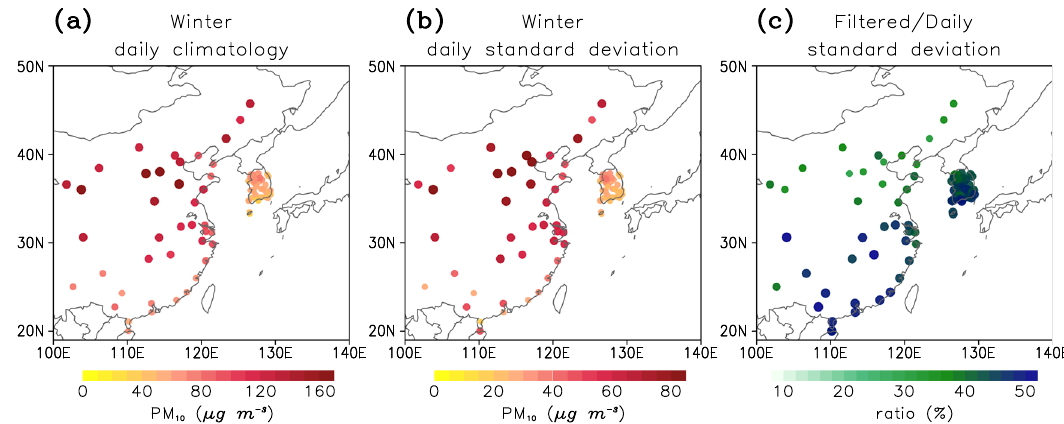
Fig. 1 | Winter PM 10 concentration in East Asia. a Daily climatology, ( b ) daily standard deviation, and ( c ) the ratio of the 20 – 96days fi ltered subseasonal standard deviation to a daily standard deviation during the boreal winter from 2001 to